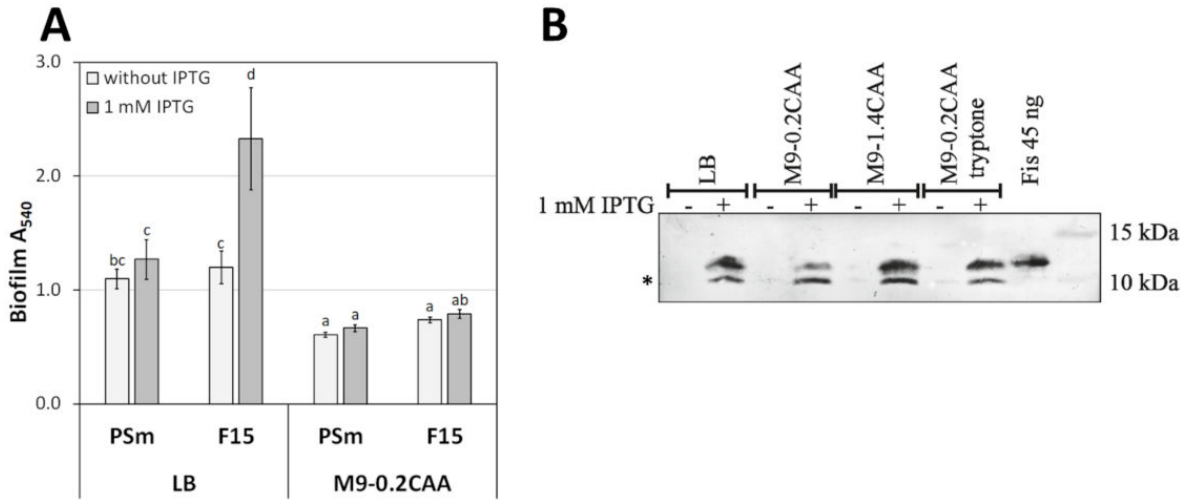
Figure 1. The biofilm of P. putida and fis -overexpression in strain F15. ( A ) The biofilm of P. putida strains PSm (wt) and F15 ( fis -overexpression strain) grown in the LB and M9-0.2CAA media in the presence or absence of 1 mM IPTG. The arithmetical averages of at least two independent measurement sets are shown. Brackets show the 95% confidence intervals, and the homogenous groups are shown above the columns by the lower-case letters. Identical letters denote non-significant differences ( p ≥ 0.05) between averages of biofilm. ( B ) Overexpression of fis in P. putida F15 by immunoblotting using monoclonal anti-Fis antibodies. A total of 10 µ g of total protein obtained from P. putida F15 grown in LB, M9-0.2CAA, M9-1.4CAA, or M9-0.2CAA+tryptone media was loaded on a 12% SDS-PAA gel. The supplementation of 1 mM IPTG is shown by "+" above the lane. A total of 45 nanograms of purified Fis (6His) was used as a positive control. An asterisk indicates proteolytically cleaved Fis. Protein marker band sizes are